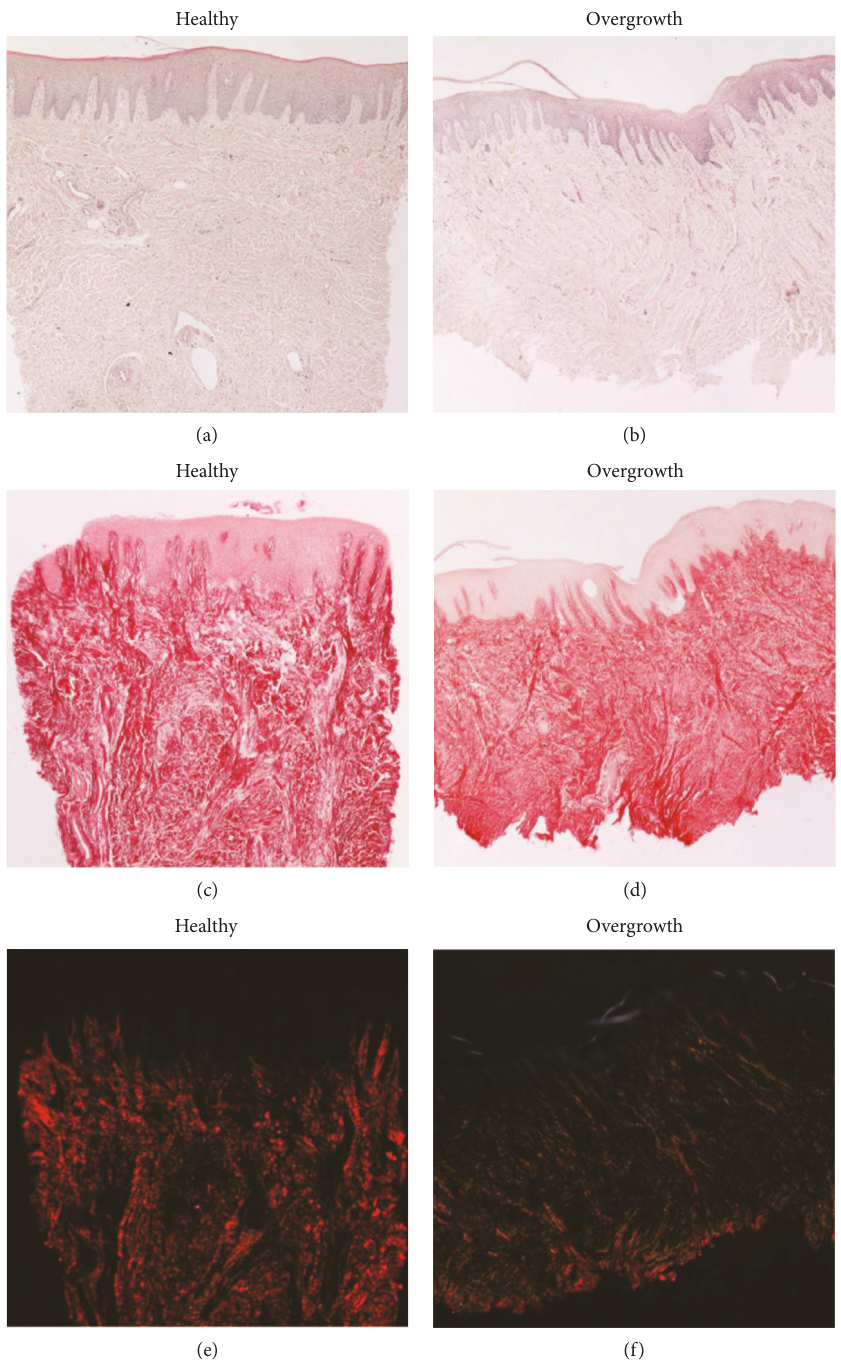
Figure 3: Micrographs showing the healthy and overgrown gingivae. (a-b) Hematoxylin and eosin staining reveals the morphological structure of the epithelium and of the connective tissue. (c-d) Sirius Red staining stains in red the collagen fi bers of the connective tissue. (e-f) Polarized light performed on Sirius Red-stained samples shows birefringence relative to collagen fi ber arrangement and maturation. Original magni fi cation: